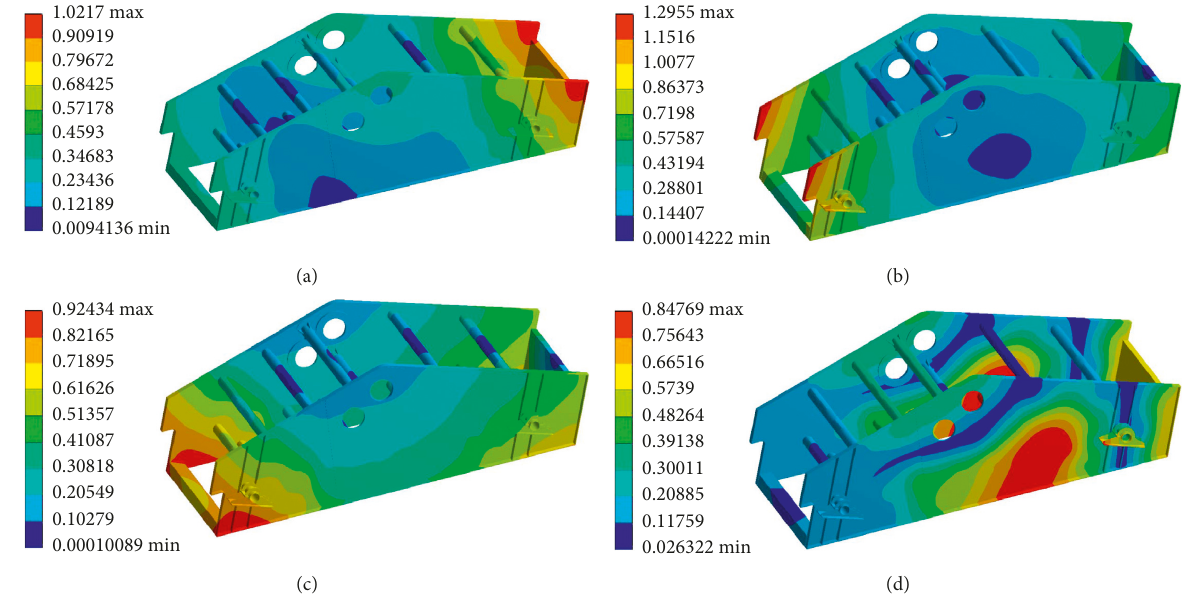
Figure 7: Modal picture of vibrating screen (7 ∼ 10 order). (a) 7 order. (b) 8 order. (c) 9 order. (d) 10 order. Table 4: Modal calculation results of vibrating screen (7 ∼ 10 order). Order Natural frequency f